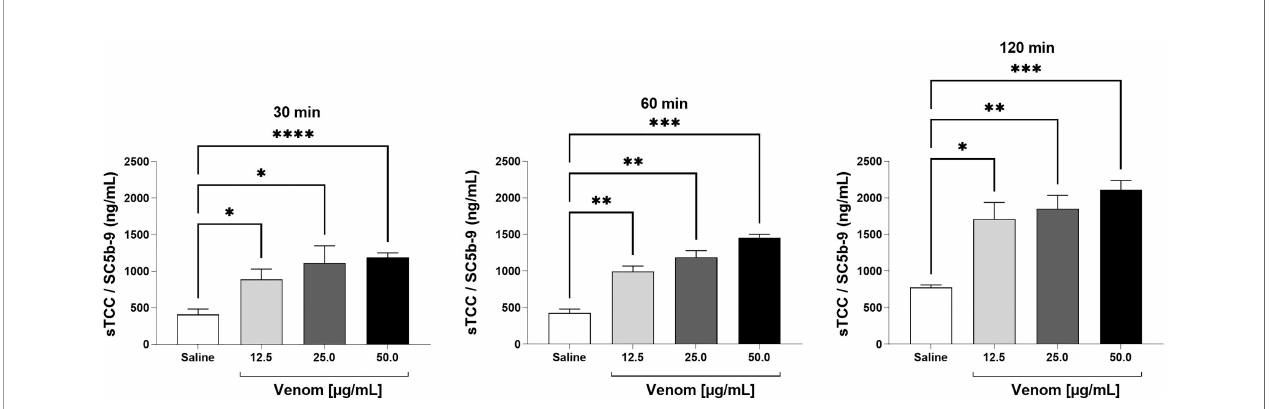
FIGURE 2 | SC5b-9 levels in human plasma after exposure to B. jararaca venom. Human blood samples containing the peptide GPRP (8 mg/mL) were incubated with increasing concentrations of B. jararaca venom or sterile saline solution for 30, 60 and 120 minutes at 37°C. After plasma collection and dilution (1:40), the presence of the soluble complement terminal complex (sTCC, SC5b-9) was analyzed by ELISA. The results are represented as the mean ± SEM of duplicates from three independent experiments. * p ≤ 0.05, ** p ≤ 0.005, *** p ≤ 0.0005, **** p